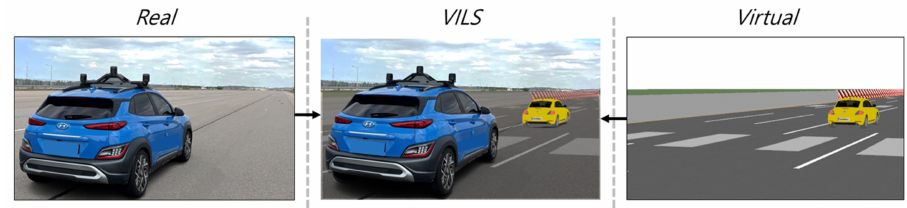
Figure 1. Concept of PG-based